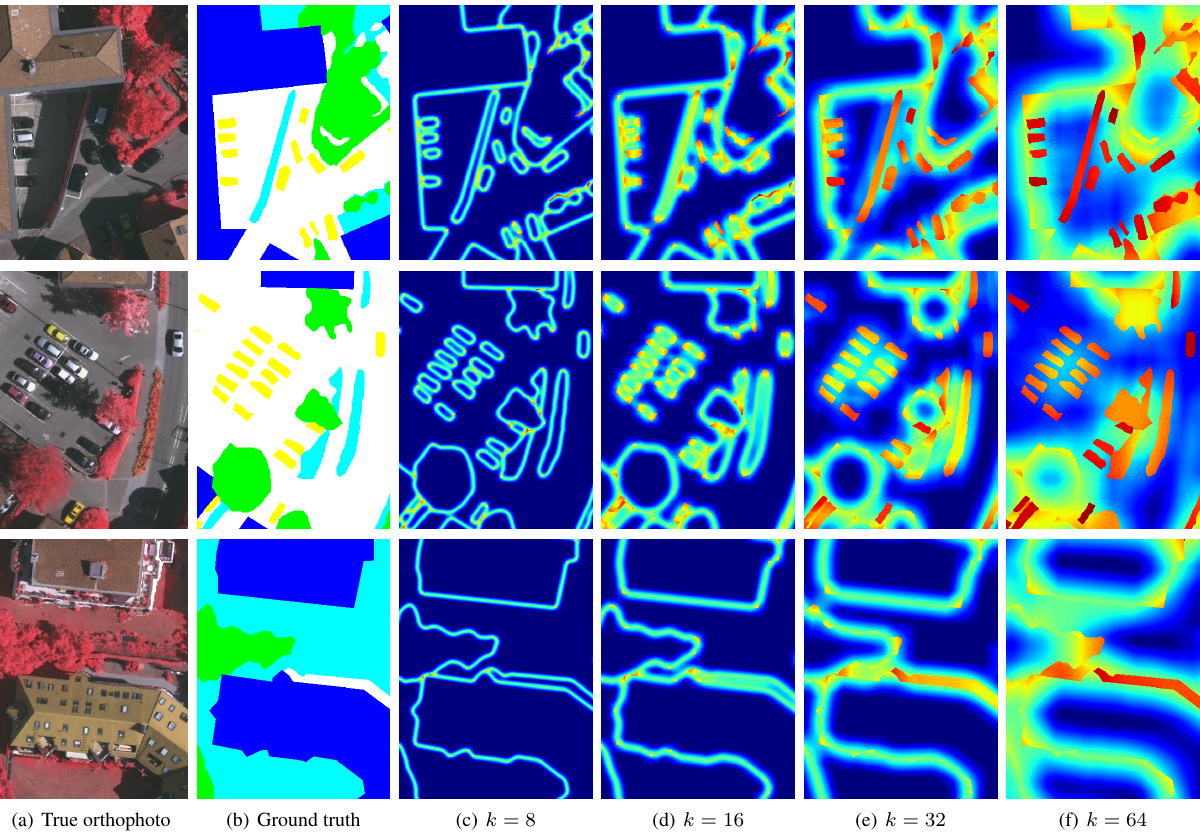
Figure 4. The effect of neighboring pixel affinity maps with the search region k = 8 , 16, 32, and 64. The higher the value of the pixel closer to the small-sized objects and object boundaries. The affinity map is only calculated based on ground truth.